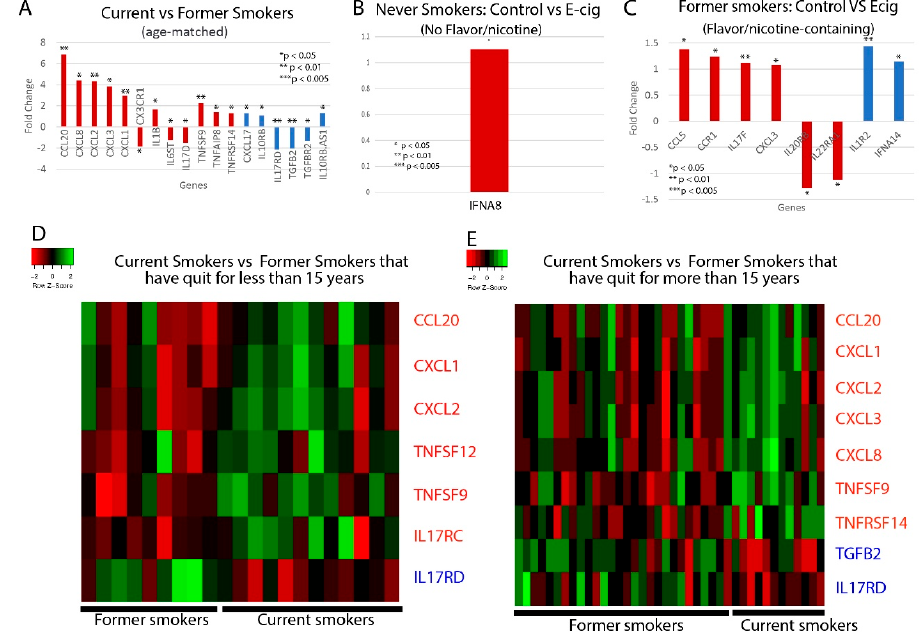
Figure 2. Cytokine-related gene expression. Bar plots of the fold changed of significantly dysregulated cytokine genes in ( A ) current vs. former smokers; and control vs. e-cig users that have used e-cigs with ( B ) no flavors or nicotine or ( C ) with nicotine and / or flavors. Heat maps illustrating di ff erences in cytokine gene expression between current smoker and former smokers that have either quit for ( D ) less than 15 years or ( E ) more than 15 years. Heat maps are split into quadrants based on current / former smokers and pro / anti-inflammatory cytokines. Red bar plots represent proinflammatory cytokines, and blue bar plots represent anti-inflammatory